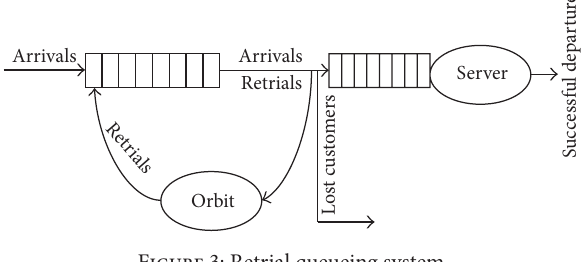
Figure 3: Retrial queueing